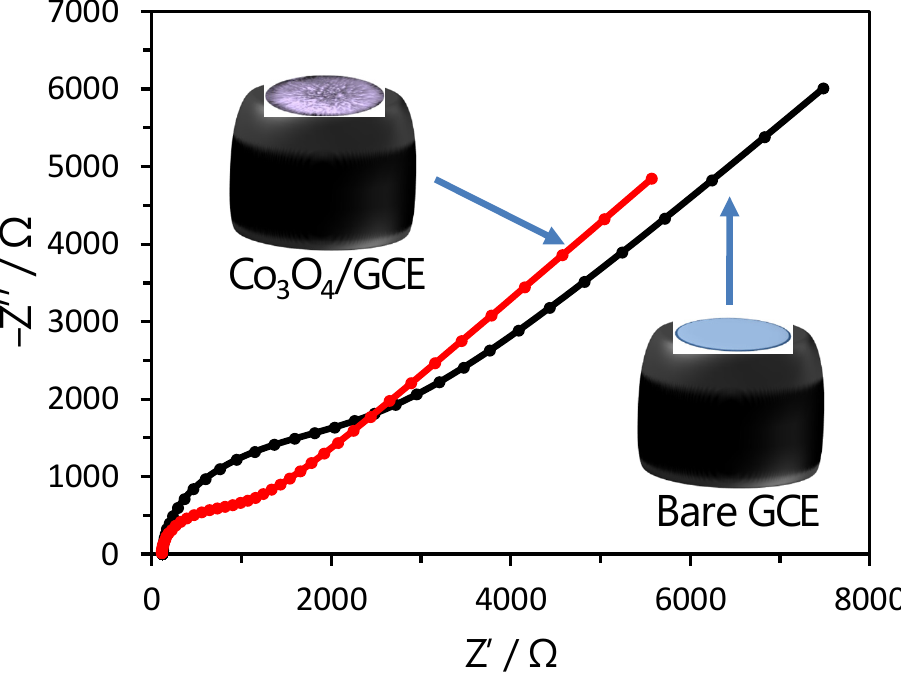
Figure 3. Nyquist plots of bare GC and cobalt oxide puffy balls/GC sensors in probe solution (5 mM, K 3 [Fe(CN) 6 ] and 0.1 M KCl); frequency range = 0.1 Hz to 10 − 5 Hz. Insets show the schemes of bare (above inset) and modified (below inset) GC electrodes.